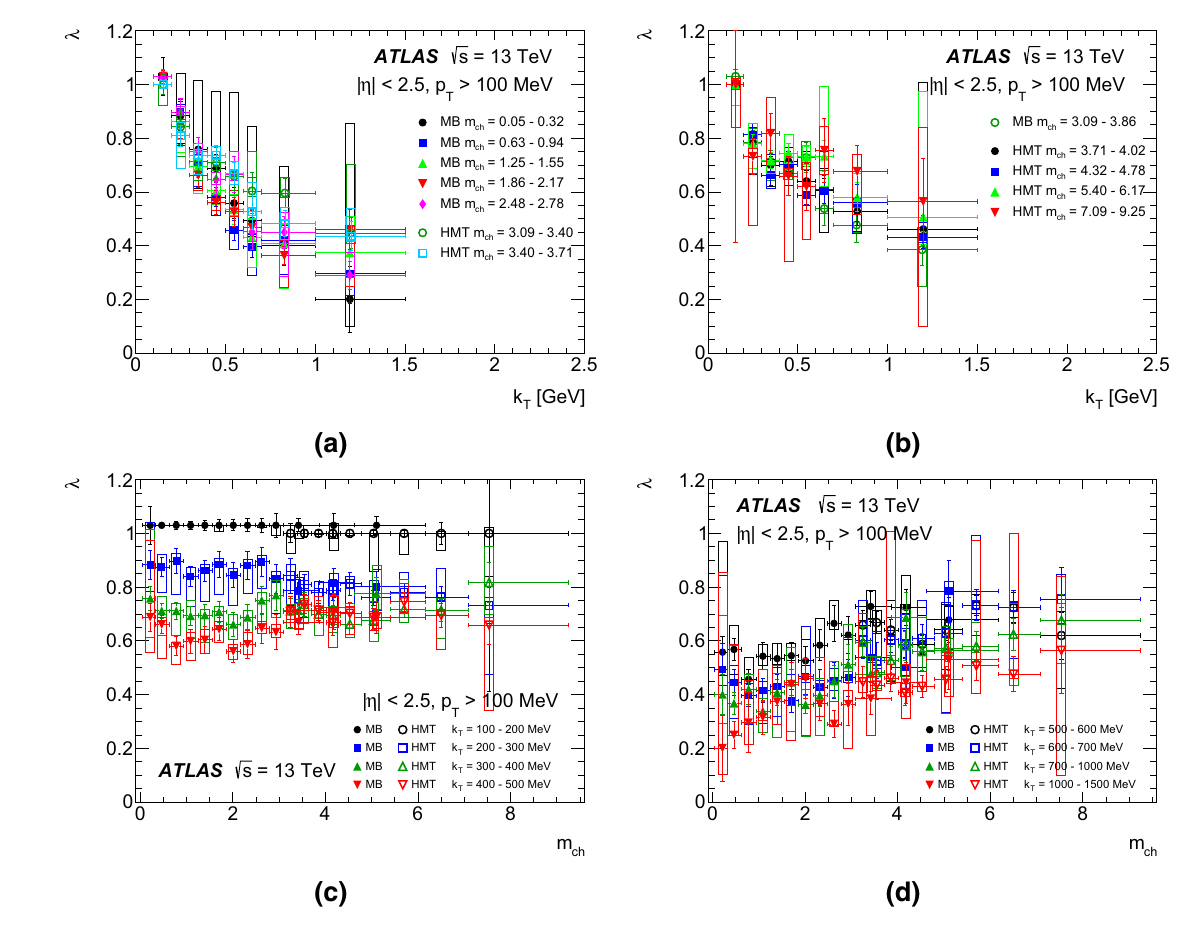
Fig. 8 The parameter λ for p T > 100 MeV: a as a function of k T in selected low m ch intervals, b as a function of k T in selected high m ch intervals, c as a function of m ch in k T intervals between 0.1 and 0.5 GeV,